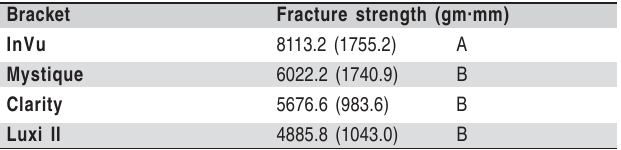
Table 1 - Fracture strength (gm·mm) of brackets submitted to arch wire torsion